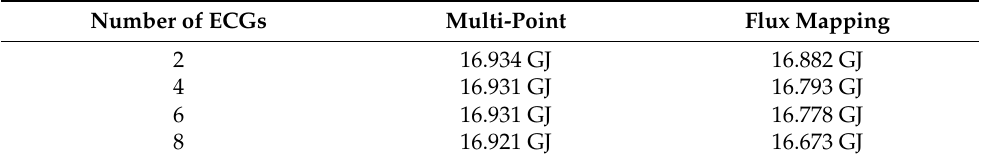
Figure 16. Efficiency map of eight ECG points with flux map method. Table 7. Comparison of drive-cycle energy consumption of the optimum motor